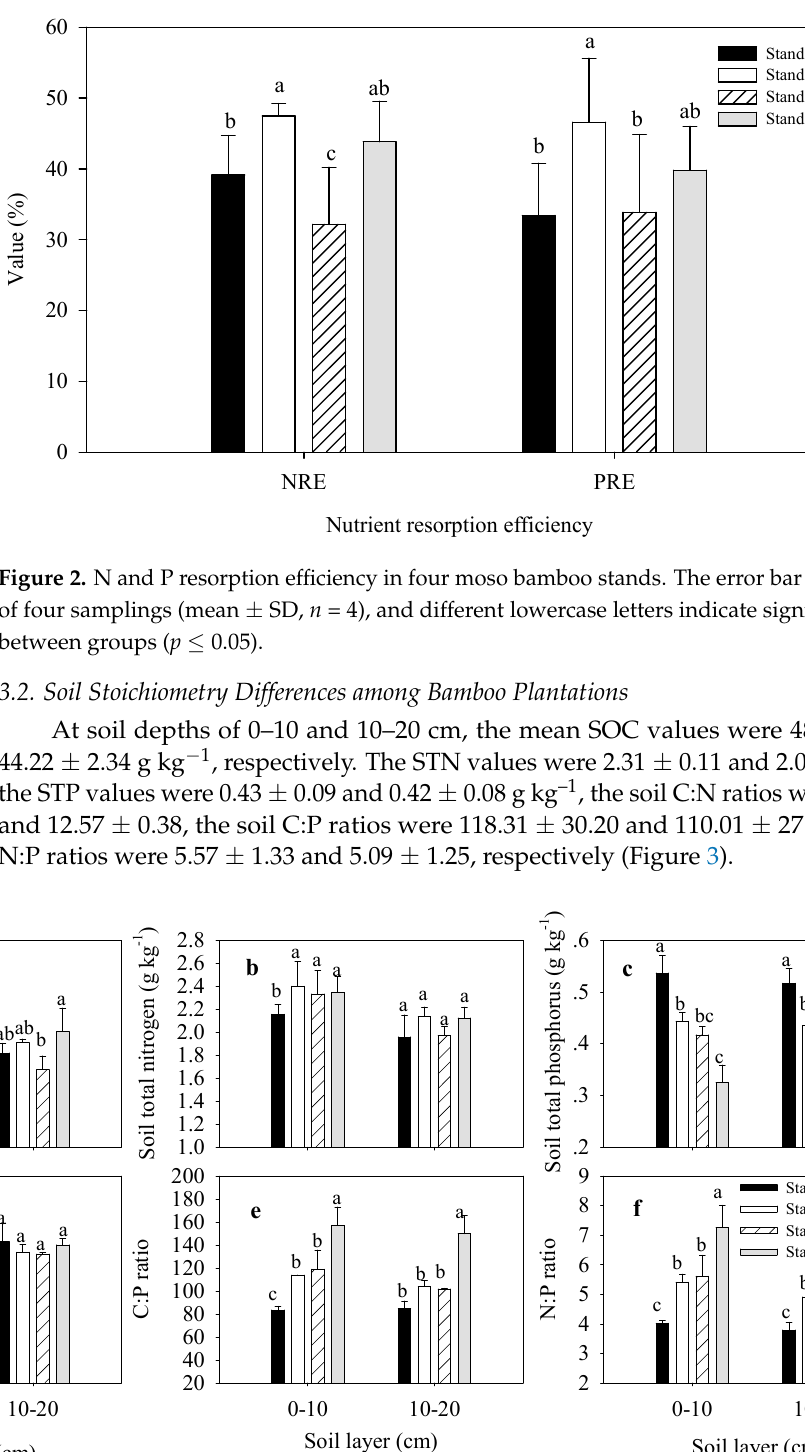
Figure 1. Carbon (C), nitrogen (N), and phosphorous (P) concentrations, and stoichiometry, in litter and leaves of moso bamboo ( Phyllostachysedulis ). The error bar was the mean value of four samplings (mean±SD, n =4), and different lowercase letters indicate significant differences between groups ( p ≤ 0.05). a–c, is the concentration of C, N, P of leaves and litter; d–f, is the stoichiometry of C:N ratio, C:P ratio and N:P ratio in leaves and litter.